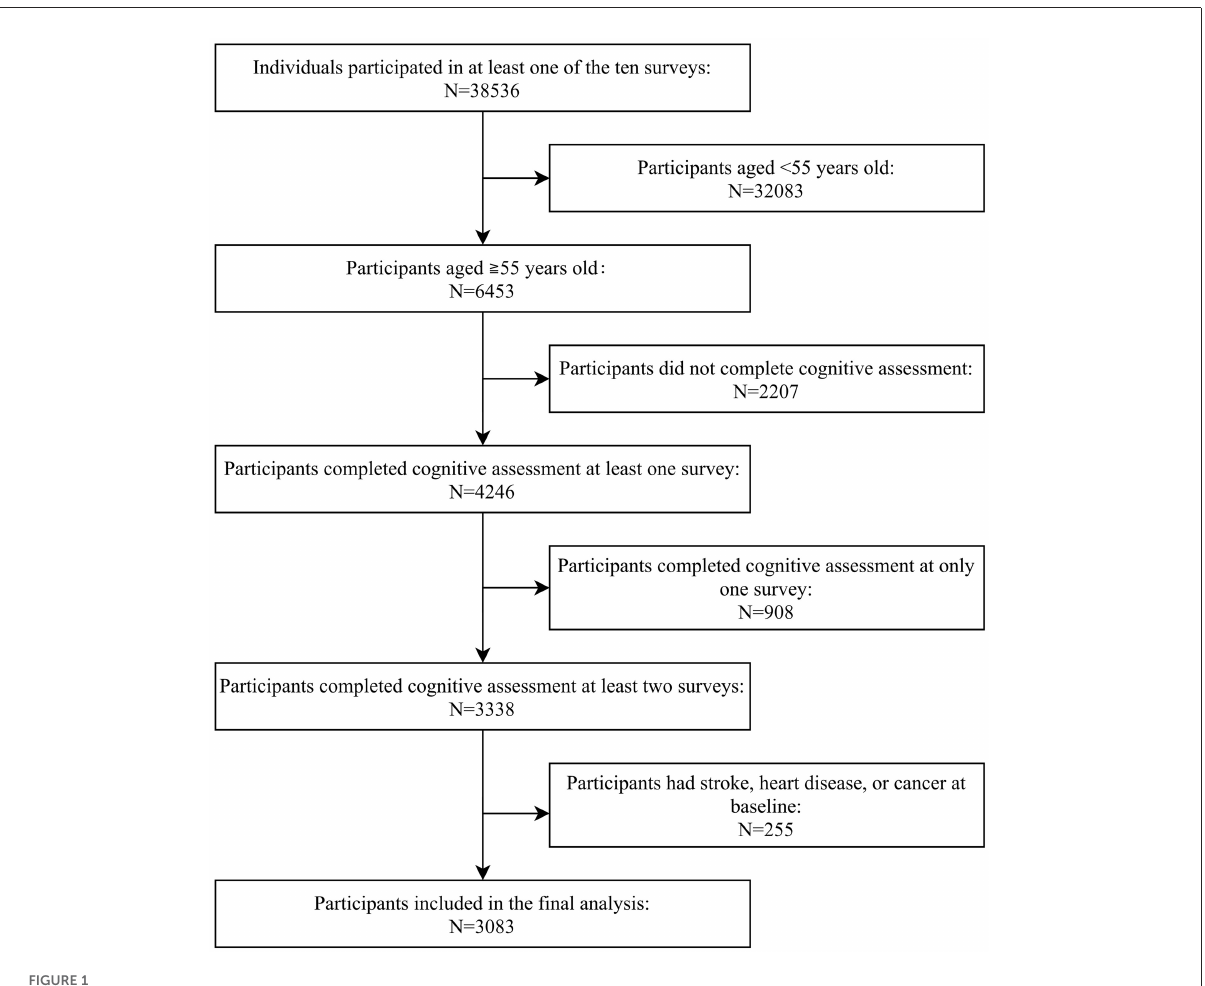
FIGURE1 Flowchart for participant